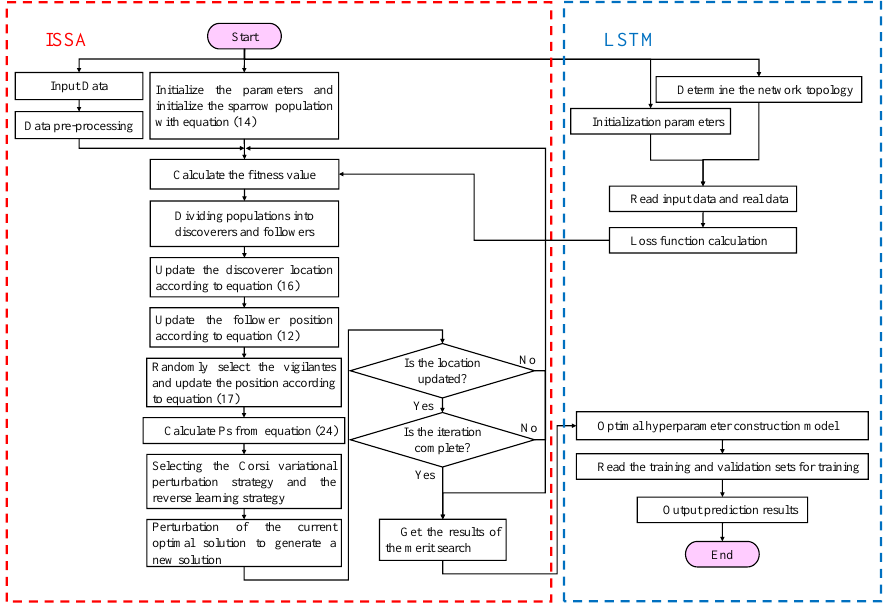
Figure 5. ISSA-LSTM algorithm flow.